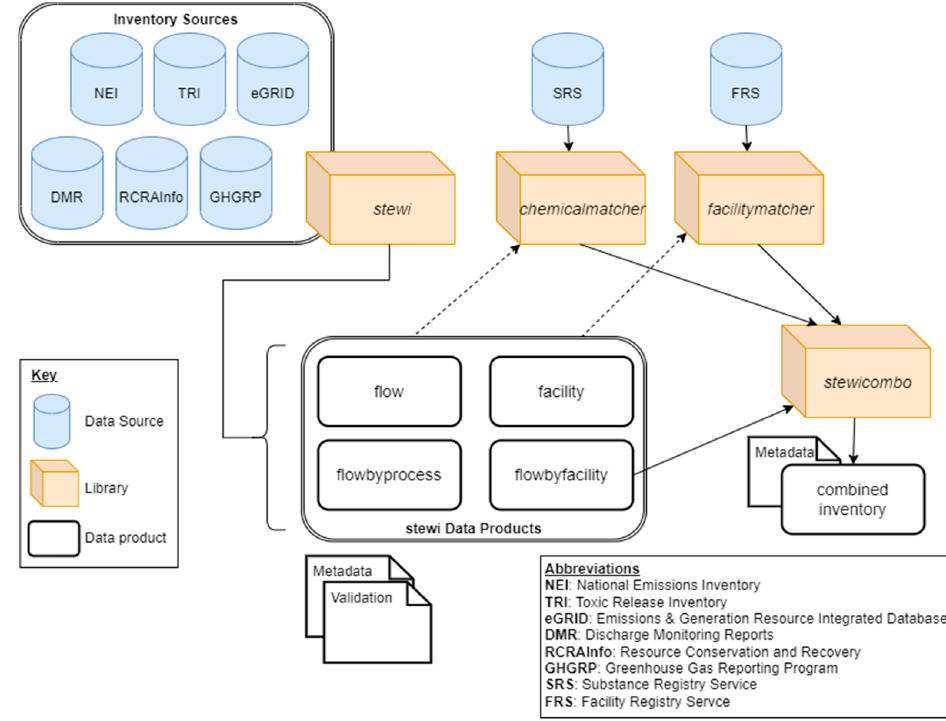
Figure 1. Standardized Emissions and Waste Inventory data flow. Table 1. Core stewi functions for processing and accessing